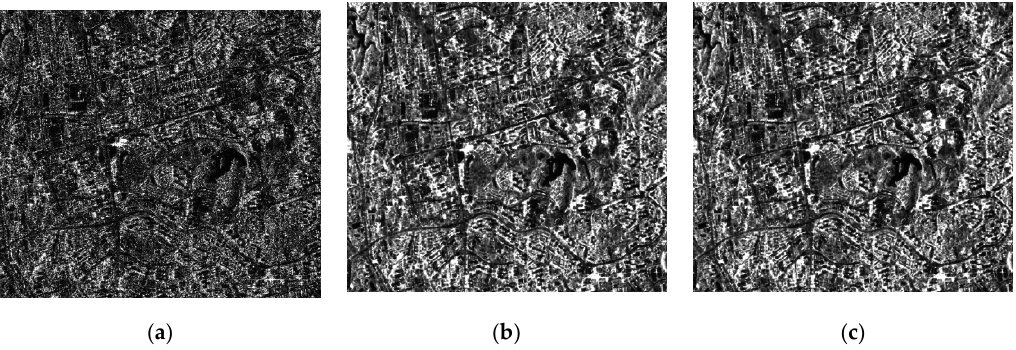
Figure 3. Polarization filtering of ALOS-2 data. ( a ) Original image; ( b ) refined Lee (window 5 × 5); ( c )